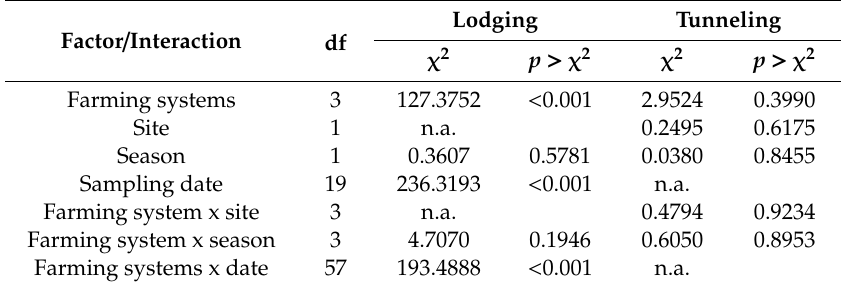
Table 2. Results of the Wald- χ 2 -Test for the fixed e ff ects on lodging and tunneling (% a ff ected plants) in the farming systems comparison trial sites at Chuka and